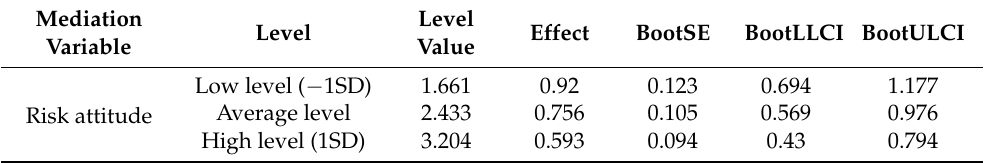
Table 8. Conditional indirect effect test